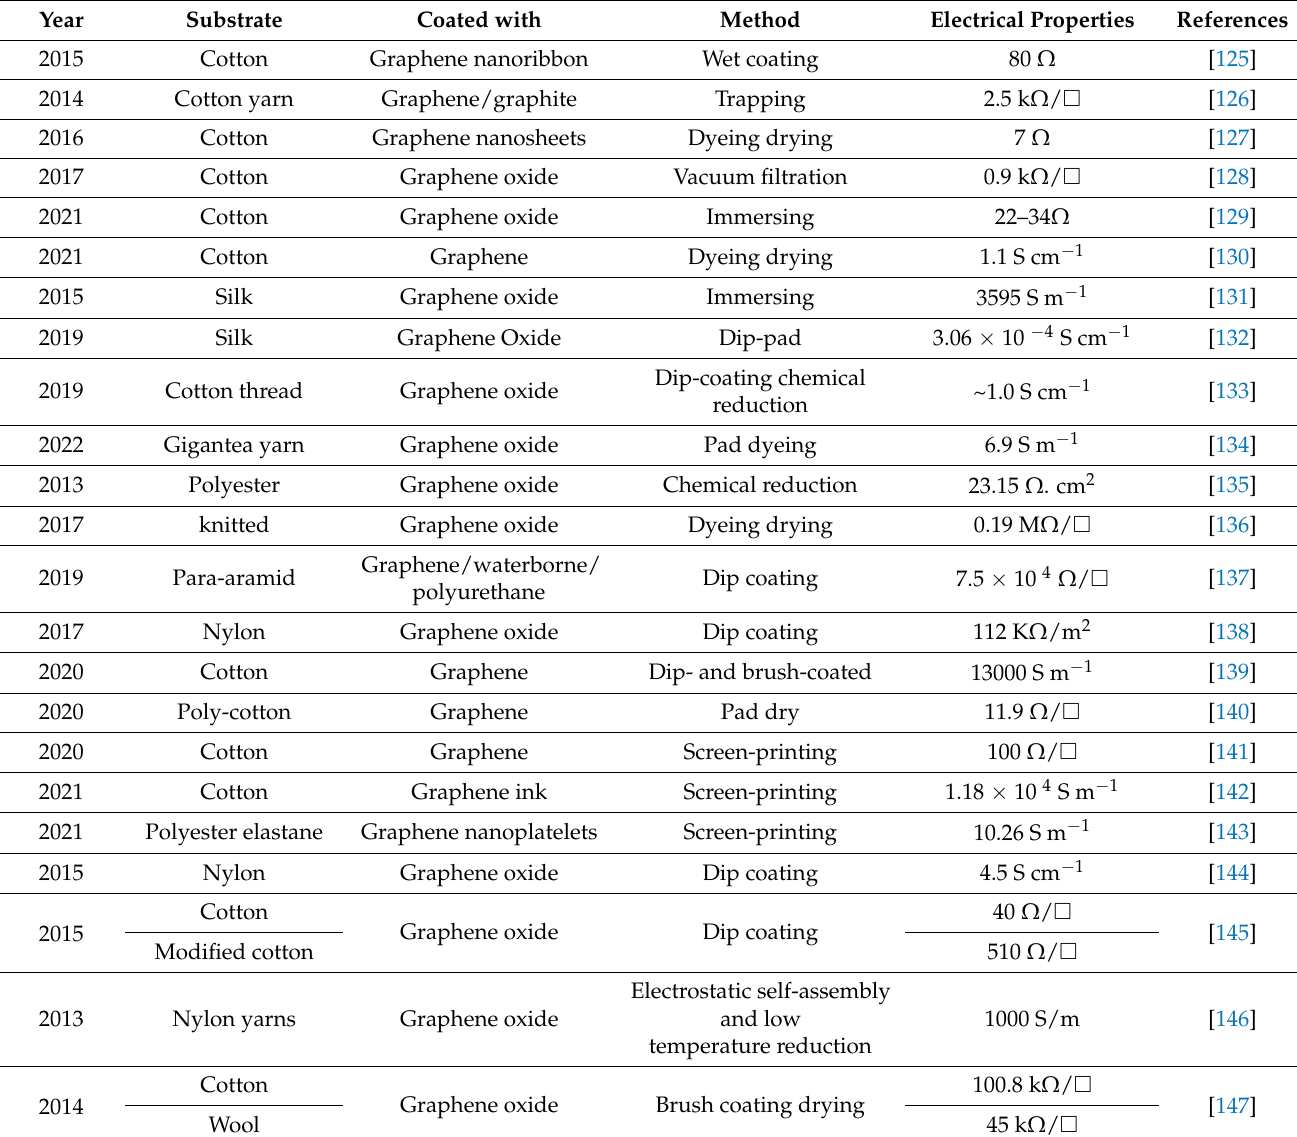
Table 6. Summary list of graphene-based materials with details of their manufacturing processes and electrical